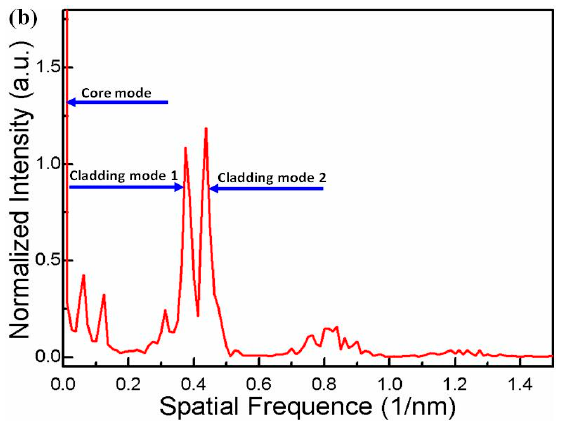
Figure 2. ( a ) Reflective spectrum of the FFPI configuration; ( b ) FFT spectrum of the reflective spectrum.